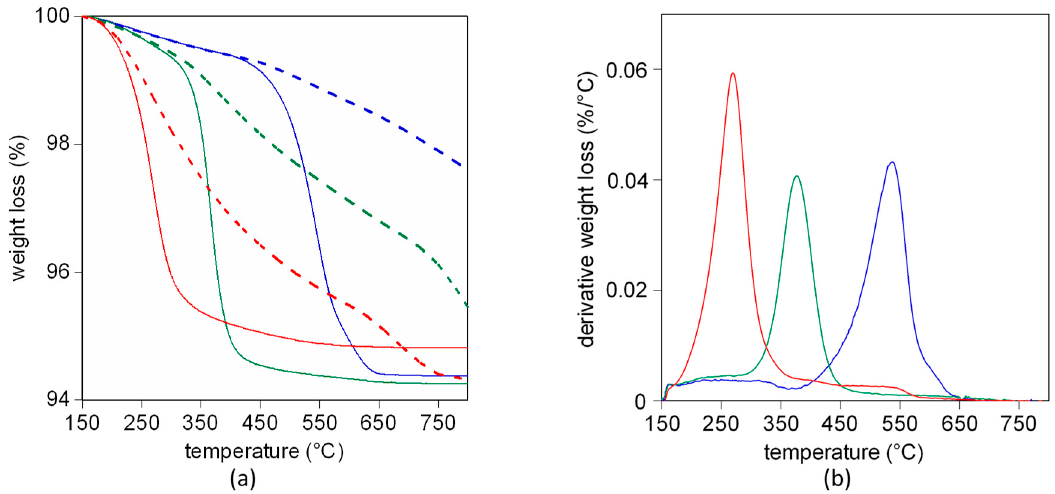
Figure 2. ( a ) Weight loss profile analysis of CZ / carbon mixtures in air (solid line) and in N 2 (dashed line) under di ff erent contact conditions and ( b ) derivative weight loss profile in air: CZ(l) (blue), CZ(t) (green) and CZ(m) (red).